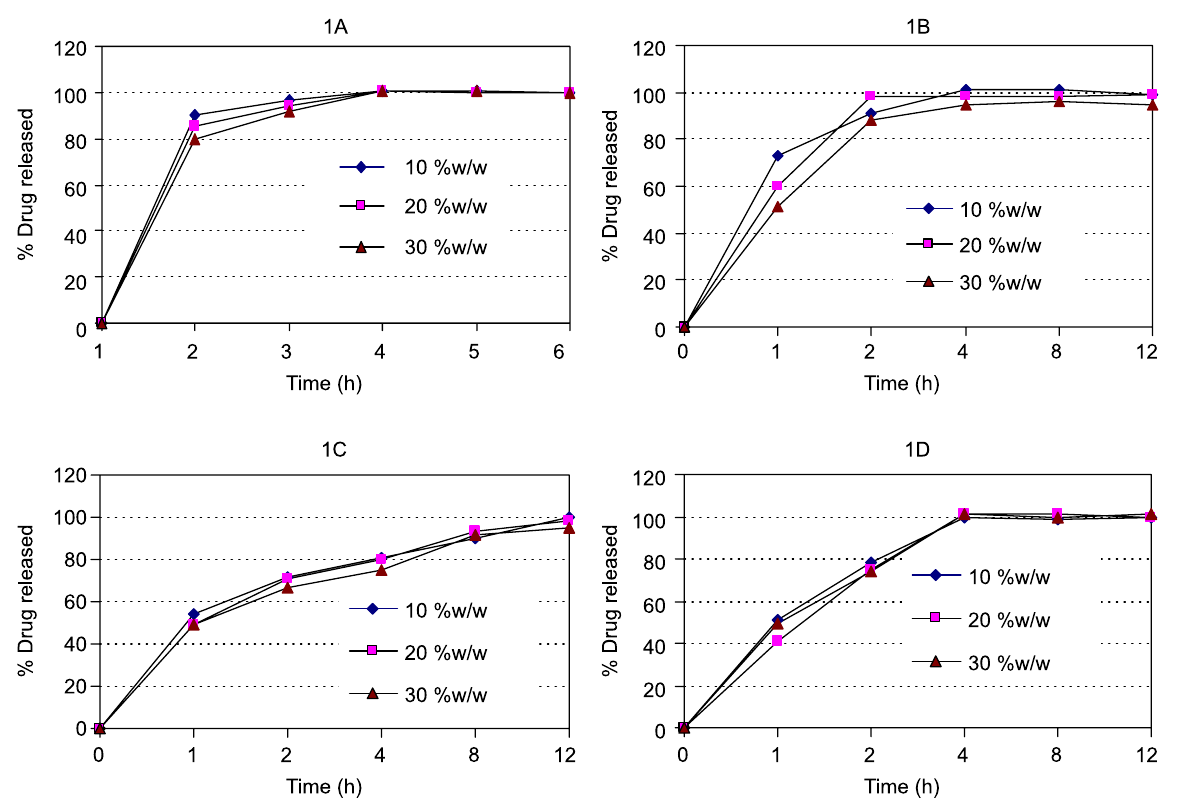
FIGURE 1 - In vitro dissolution profiles of sertraline from pellets containing 10 %w/w, 20 %w/w and 30 %w/w 1A : Aquacoat ® ECD, 1B : Eudragit ® NM30D, 1C : Eudragit ® L30D 55, 1D : Keltone ® LV